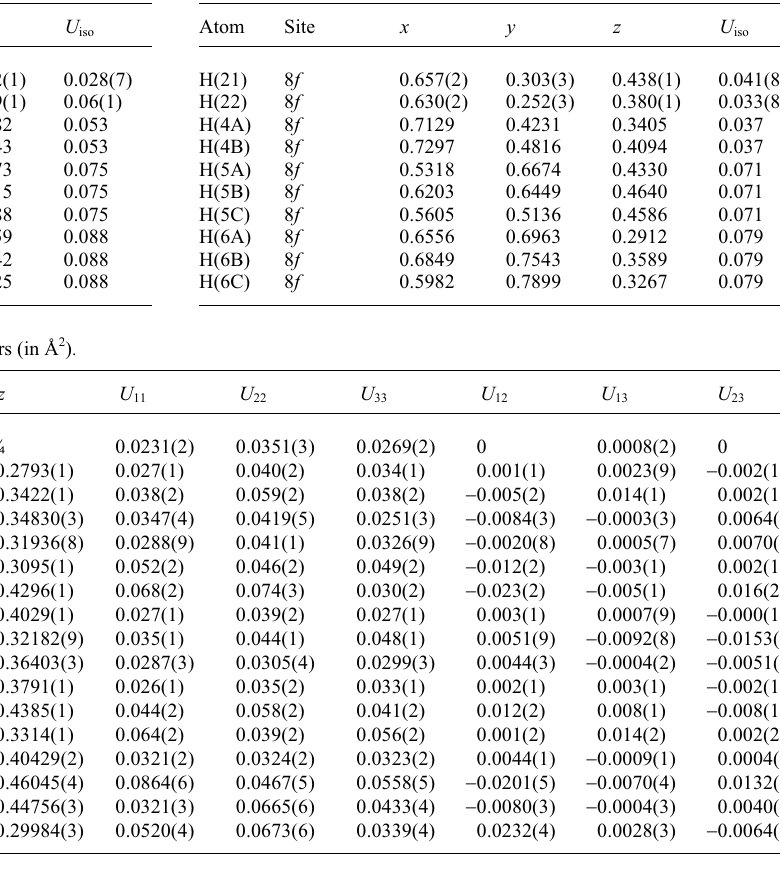
the figure) located on a twofold axis. The central Zn atom is dpma ligands and two NH groups of two of these ligands (see the 2 figure; ' = 1– x , y , 0.5– z ; for clarity methyl groups and hydrogen atoms not involved in hydrogen bonds are omitted). Three